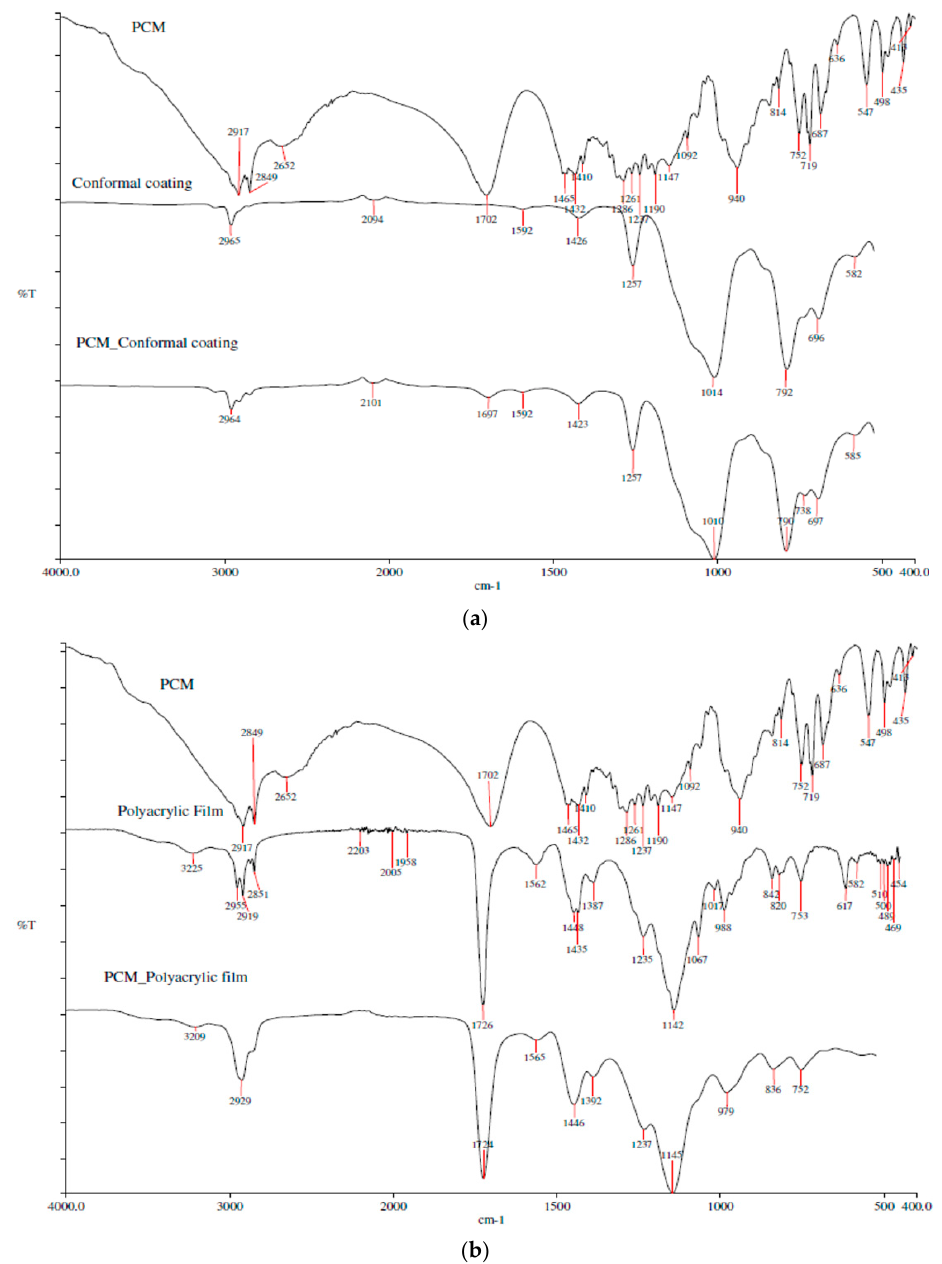
Figure 4. FTIR spectra: ( a ) PCM with conformal coating and ( b ) PCM with polyacrylic coating.